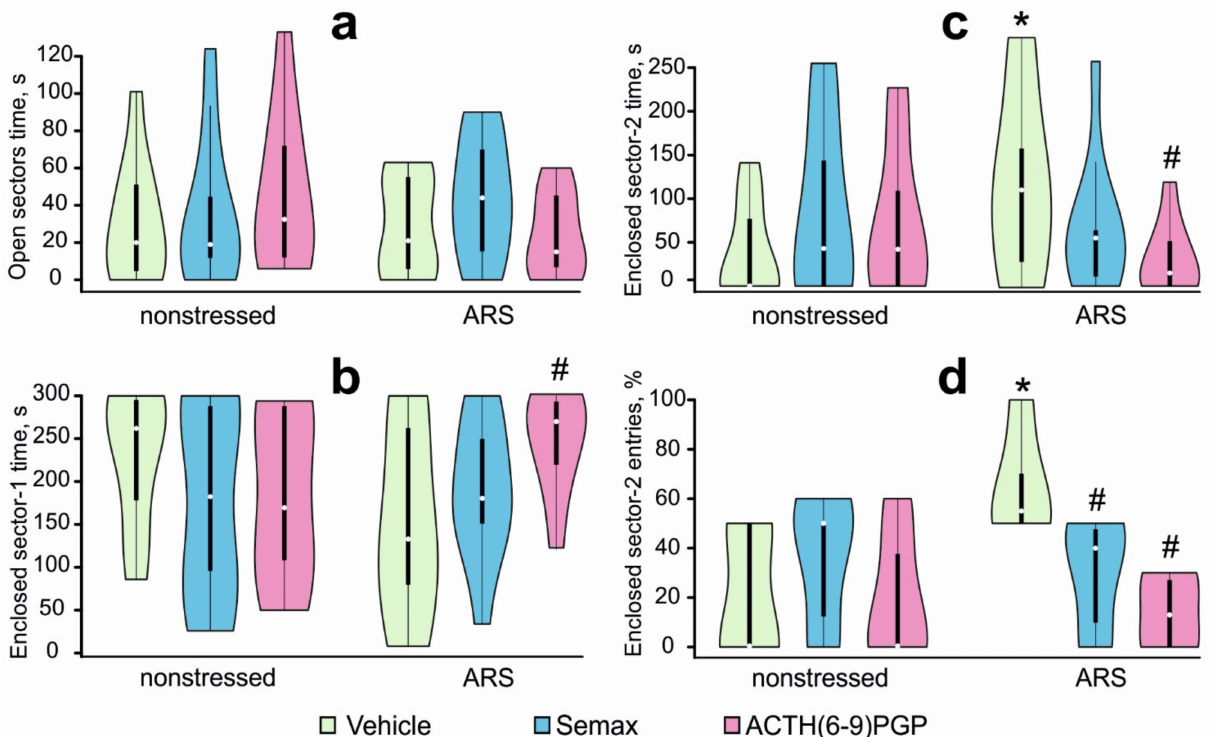
Figure 1. Effects of Semax and ACTH(6–9)PGP on rat behavior observed in the EZM 4 h after the termination of acute restraint stress (ARS). Time spent in the open sectors, s ( a ); time spent in the enclosed sector-1, s ( b ); time spent in the enclosed sector-2, s ( c ); percentage of entries in the enclosed sector-2, % ( d ) data are represented by Violin plots. Data are shown as mean ± SEM, n = 9–10 rats per group. Data were analyzed using two-way ANOVA followed by post hoc Dunnett’s test. Statistical difference is represented as * p < 0.05 versus NS-V group and # p < 0.05 versus STR-V